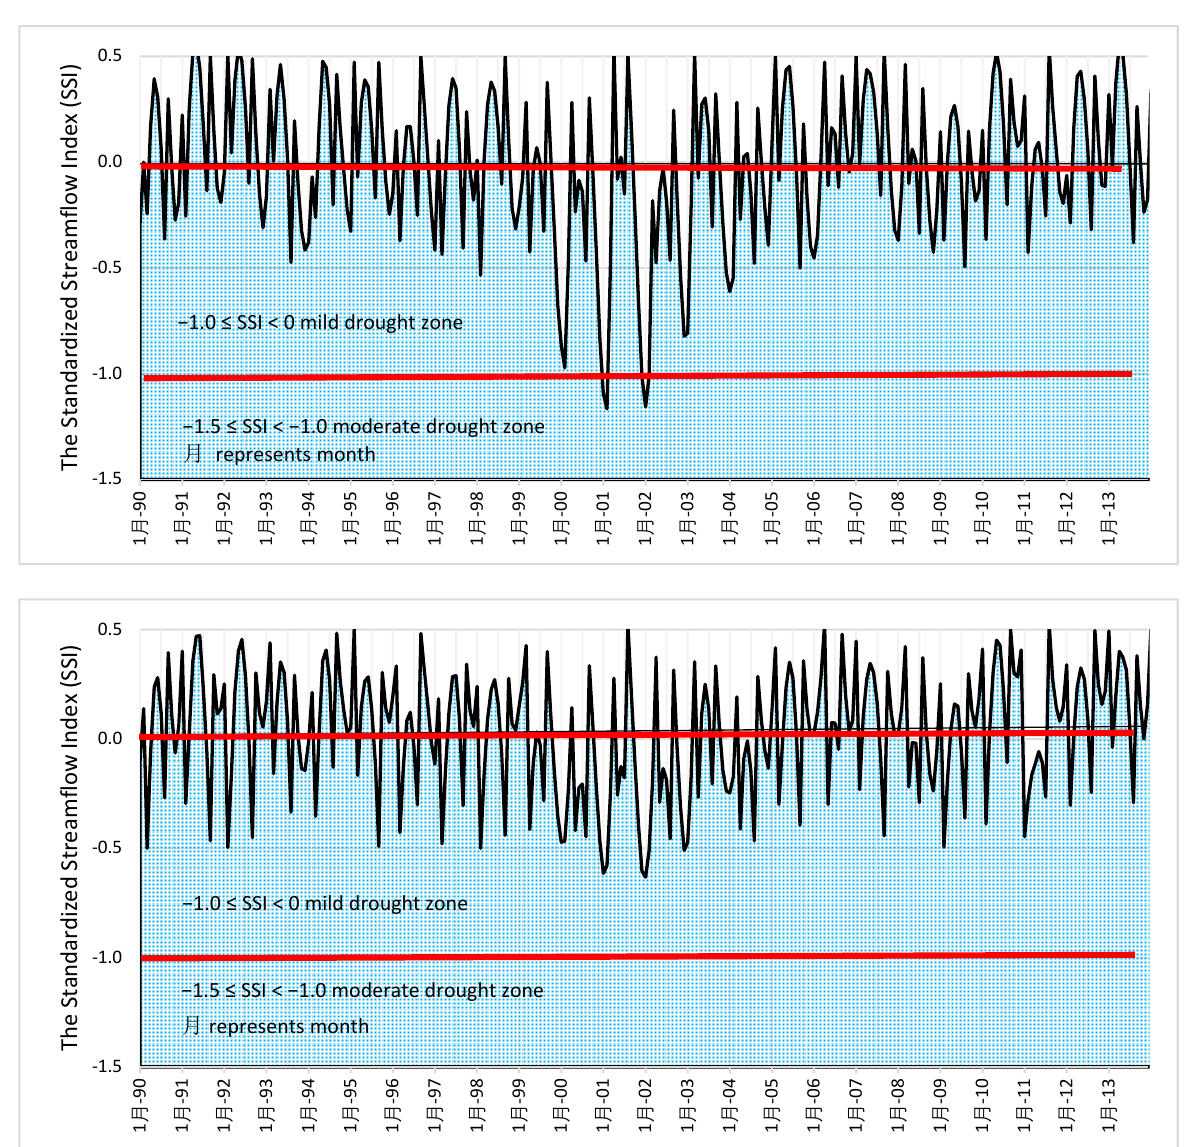
Figure 6. The Standardized Streamflow Index (SSI) for KRB flows at the Dakah Station without ( top figure ) and with ( bottom figure ) the low flow augmentation benefits of the proposed series of large dams.